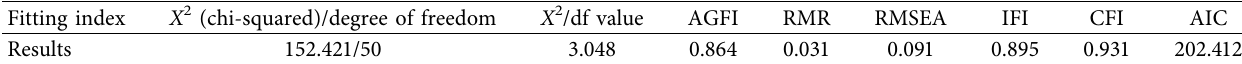
Figure 4: Structural equation model for public satisfaction with ICH digital display. Table 5: Common fitness indices.